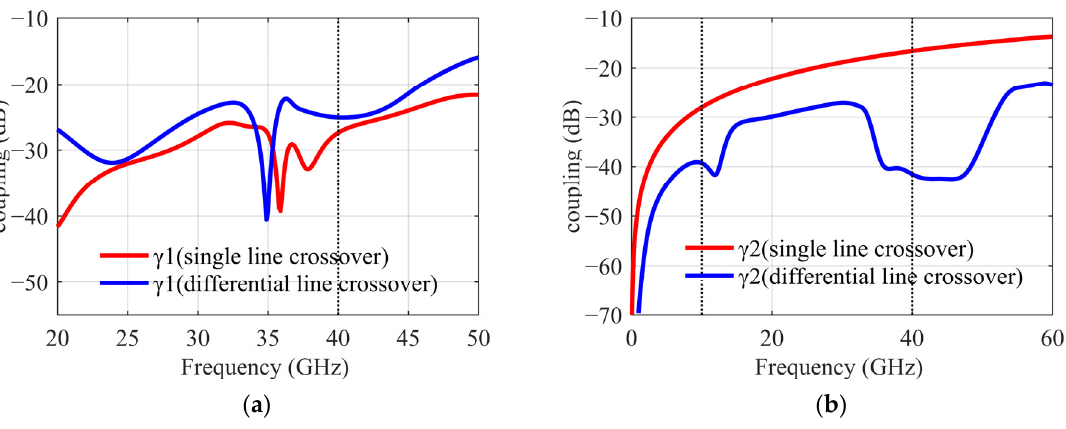
Figure 17. ( a ) Coupling 𝛾